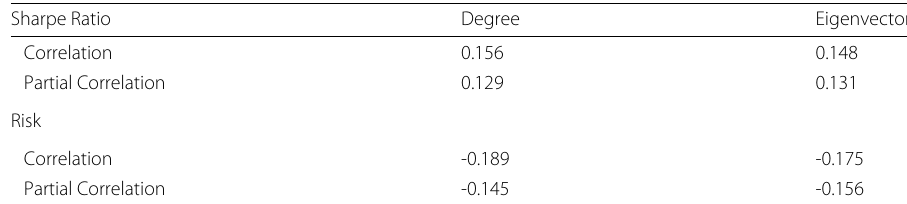
Table 1 Spearman correlation between the centrality measures and the out of sample risk and Sharpe